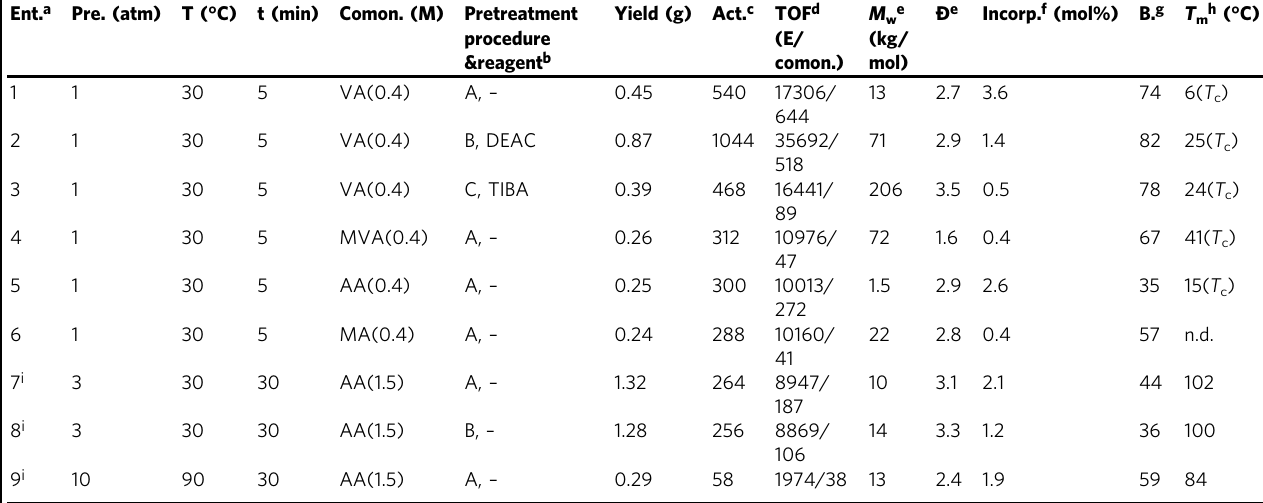
Table 3 Ethylene/AA (or VA) copolymerization catalyzed by precatalyst